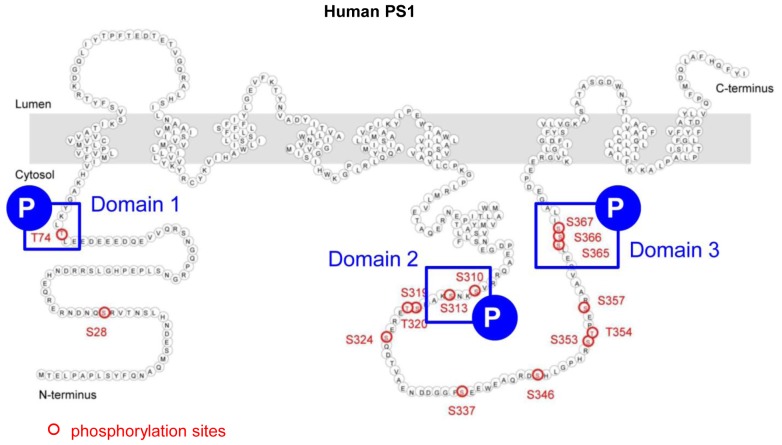
Schematic image of the three domains in PS1 involved in Ca2+-triggered pathogenic ‘closed’ conformation.This figure is related to the data displayed in Table 1. Schematic image of PS1 molecule and the three domains involved in Ca2+-triggered PS1 pathogenic ‘closed’ conformation (blue squares). Serine/threonine residues known to undergo phosphorylation are shown by red circles.